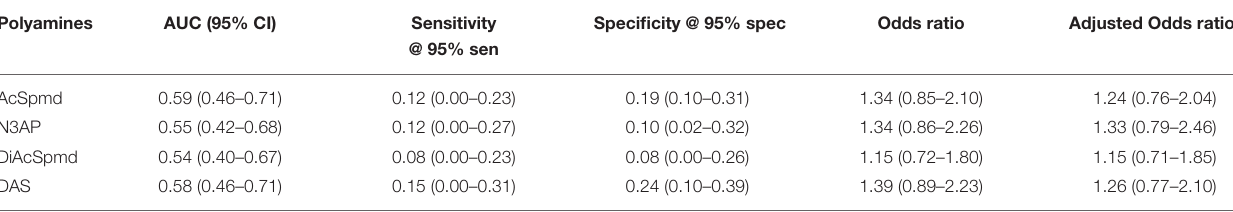
TABLE 2 | Performance estimates of polyamines for distinguishing RCB-II/III from RCB-0/I. Polyamines